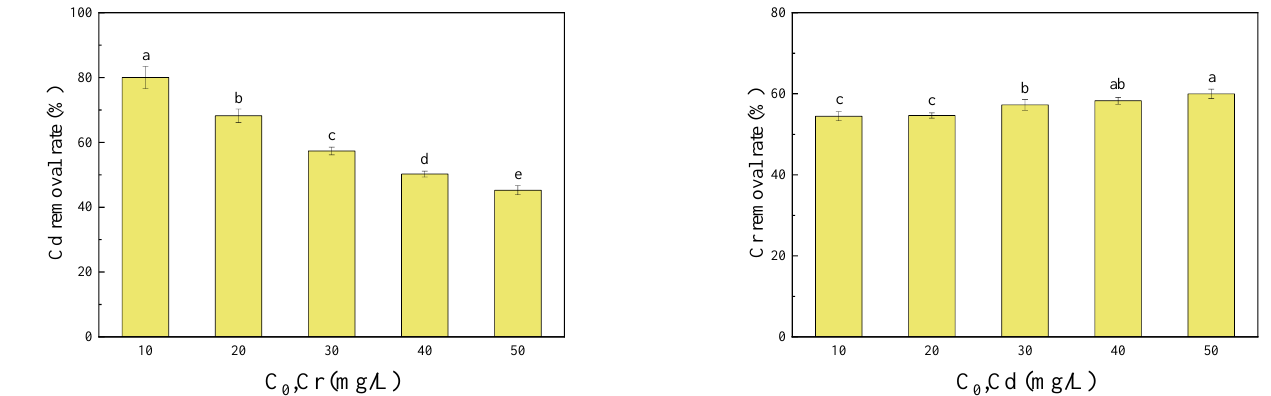
Figure 5. Effects of the initial concentrations of Cr(VI) or Cd(II) on their removal rates in a binary system. Different letters on bars indicate significant differences at p < 0.05 between treatments.